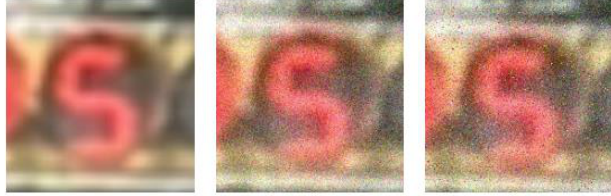
Figure 10. Data enhancement results.